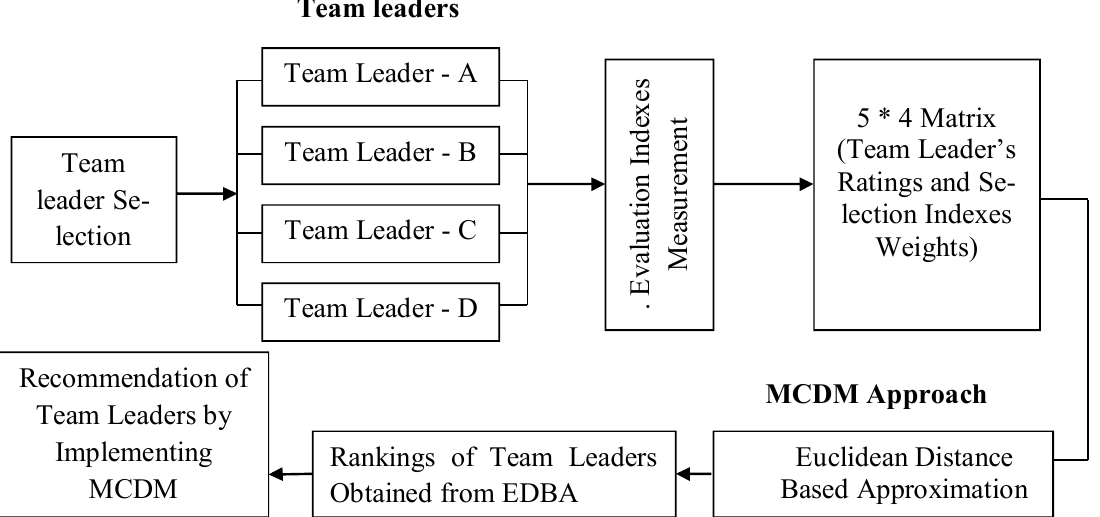
Fig 1. Team Leader Selection Process